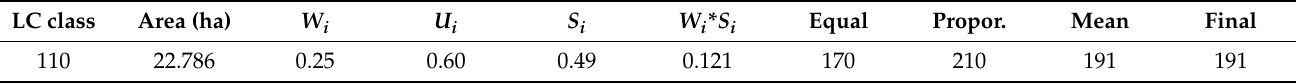
Table A3. Calculation of the sample size of the land cover map of the municipality of Rome from single-date summer image classification after the application of the “erosion”